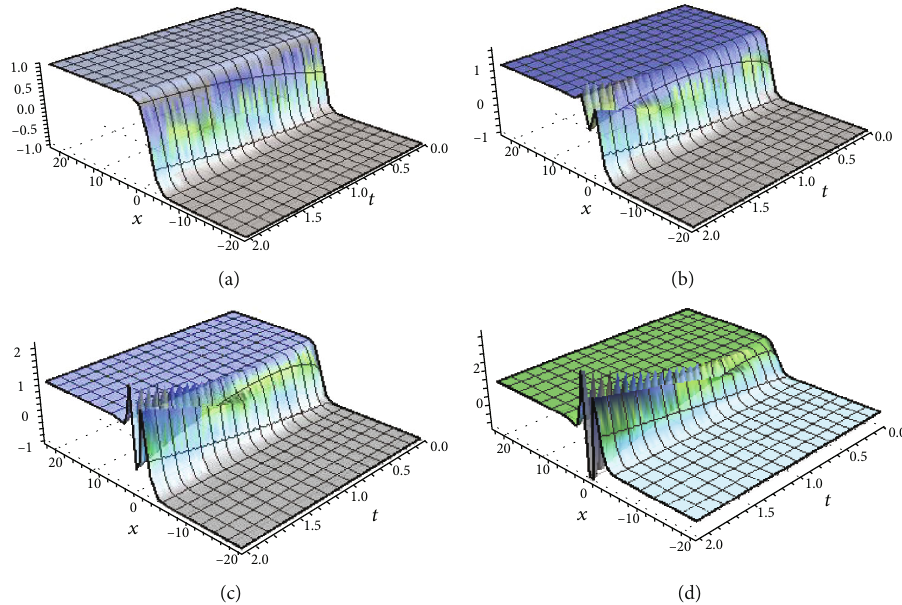
x , t Þ of the FCH4 model (40) and (41) with μ = 1 for diverse α : (a) exact, (b) α = 0 : 75 , (c) α = 0 : 5 , Figure 3: Surface wave behavior of u 4 ð and (d) α = 0 : 25